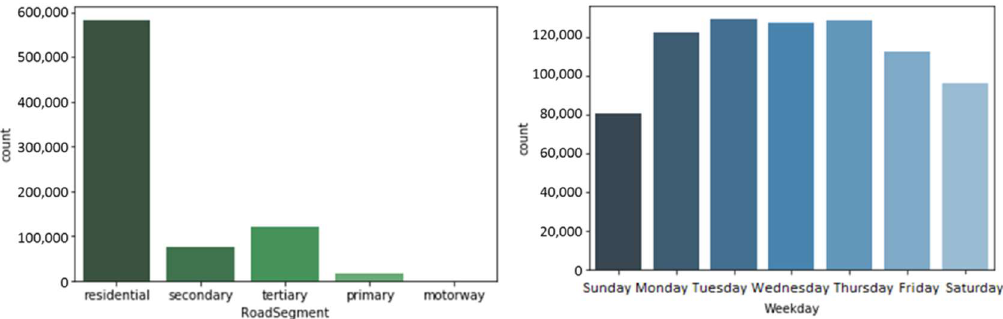
Figure 1. Session count by road segment ( left ) and weekday ( right ) on the dataset.